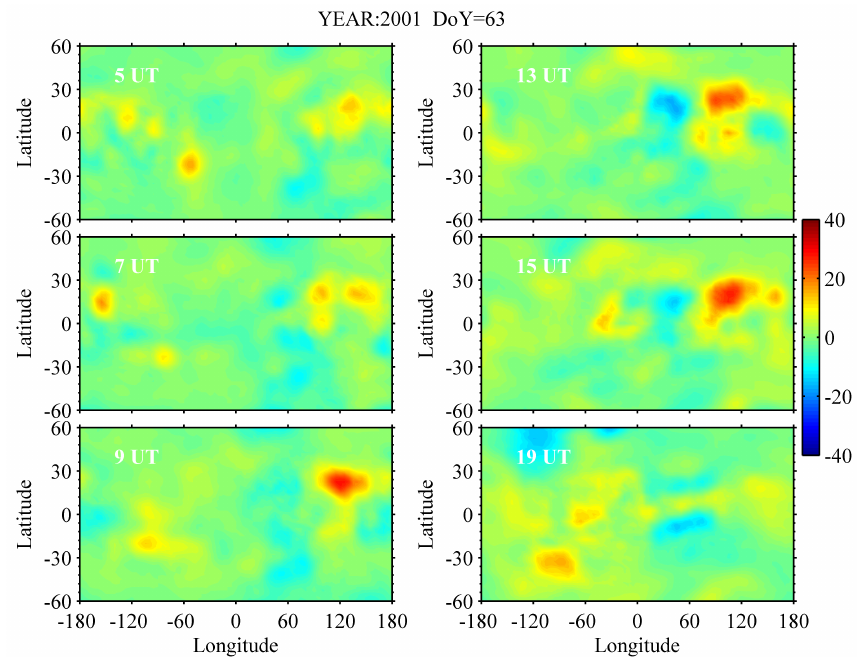
Fig. 5. Same as Fig. 2, but for the event on 4 March 2001. The median values are evaluated from the 31-day observations centered on 4 March 2001.